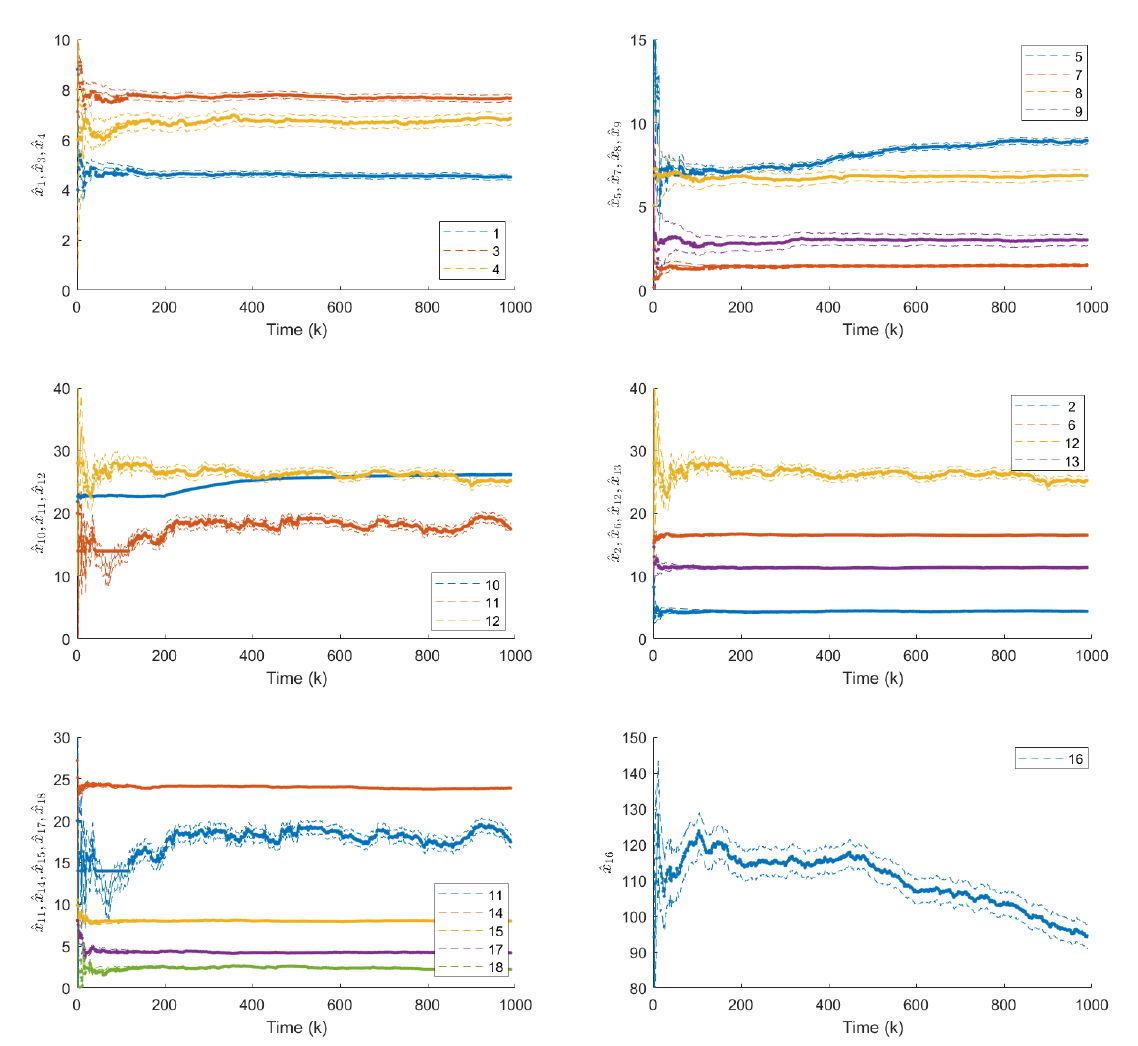
Figure 8. Estimated primary activity times with their p = 0.01 confidence intervals (represented by dashed lines). The figure illustrates that the algorithm is able to track the changes in the x 10 ( k ) , x 5 ( k ) and x 16 ( k ) activity times after the 200th, 300th and 500th product, respectively. The bold lines represent the constrained parameter